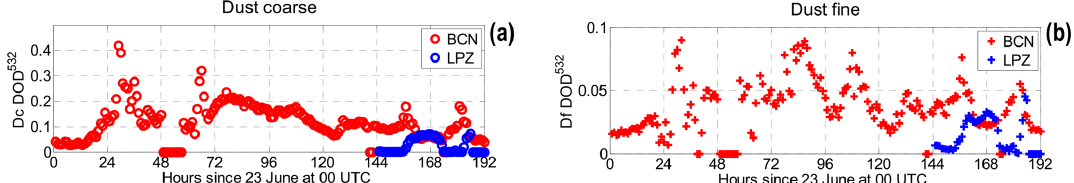
Figure 4. Hourly dust optical depth calculated from the extinction profiles for (a) the coarse mode and (b) the fine mode obtained using the POLIPHON algorithm in BCN (red) and LPZ